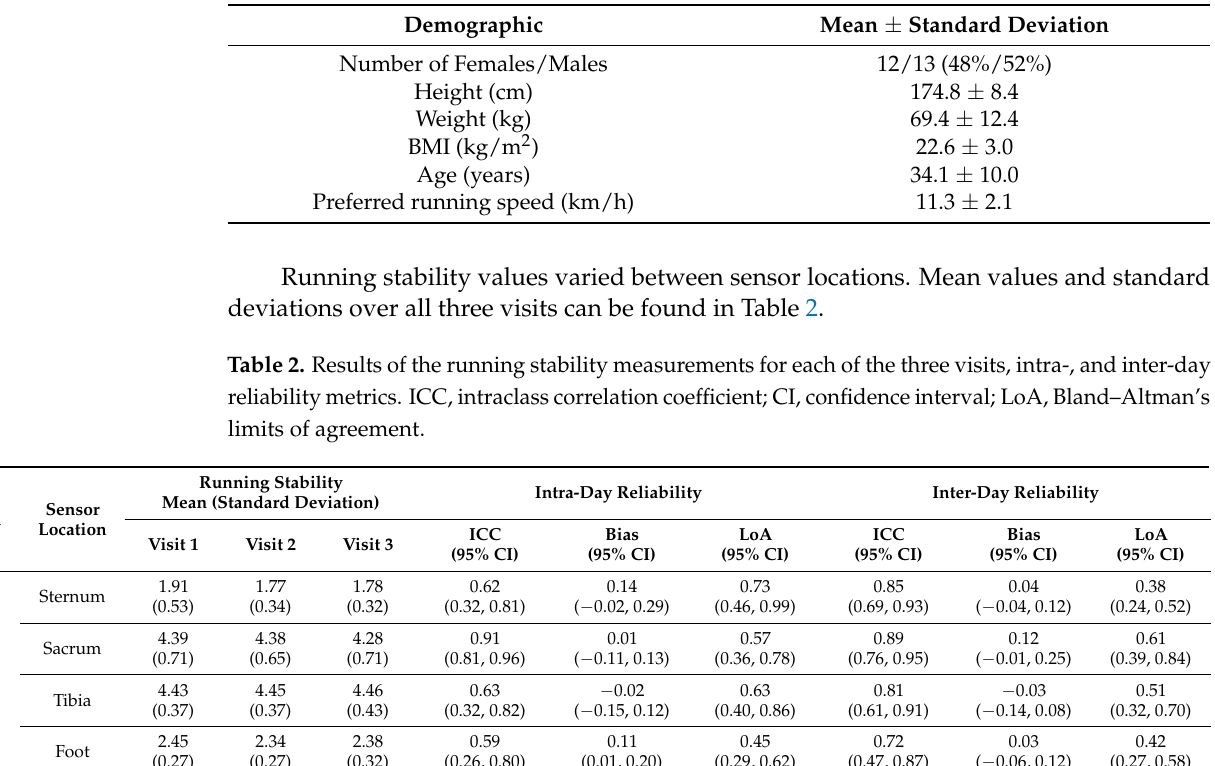
Table 1. Participant demographics.